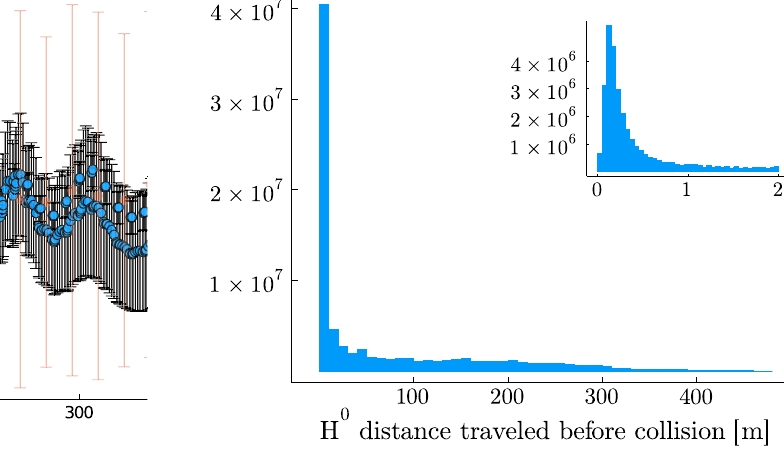
5. IBST power losses for a nominal trajectory and a corresponding error study for an H − linac identical to that in Fig. 4. Both static and dynamic machine errors and beam misalignment were incorporated, with standard deviations taken from the cumulative trajectories of 100